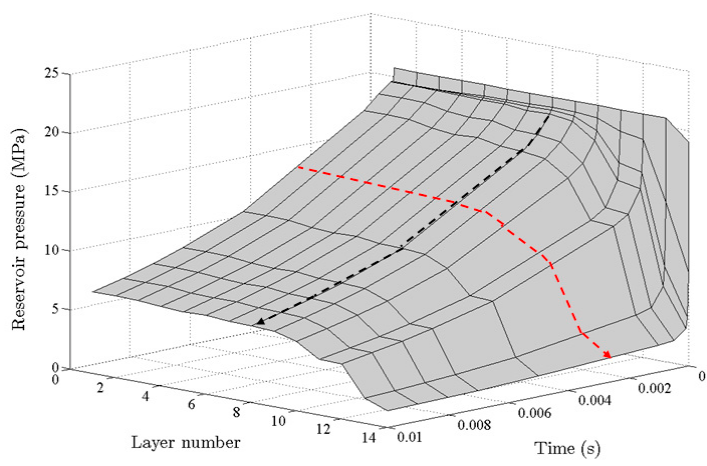
Figure 4. Variation of Knudsen number with reservoir gas pressures.